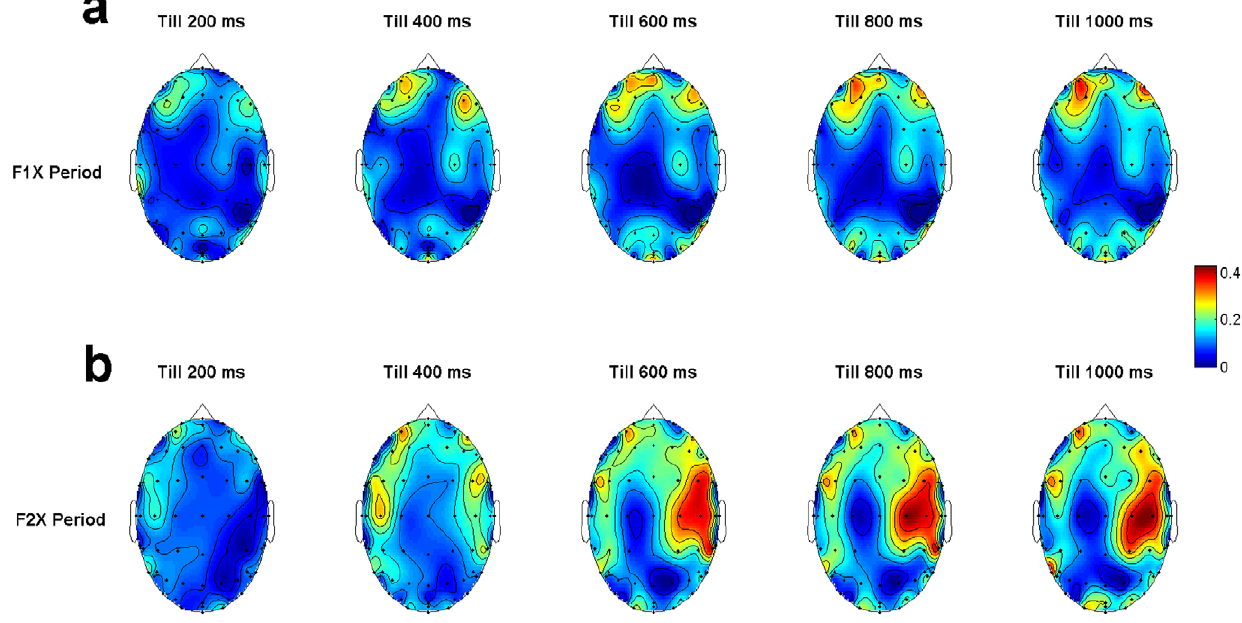
Figure 3. Scalp maps of average F -ratio distribution for CGM analysis at different time periods. ( a ), ( b ) Analysis for F1X and F2X, respectively. Note that the frontal electrode region has higher F -ratio in case of F1X while right temporal electrode region has higher F -ratio for F2X.